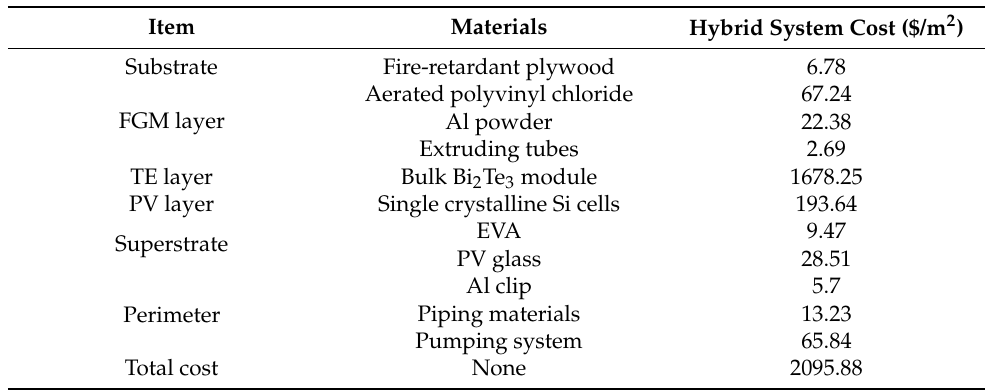
Table 4. Cost analysis of the hybrid